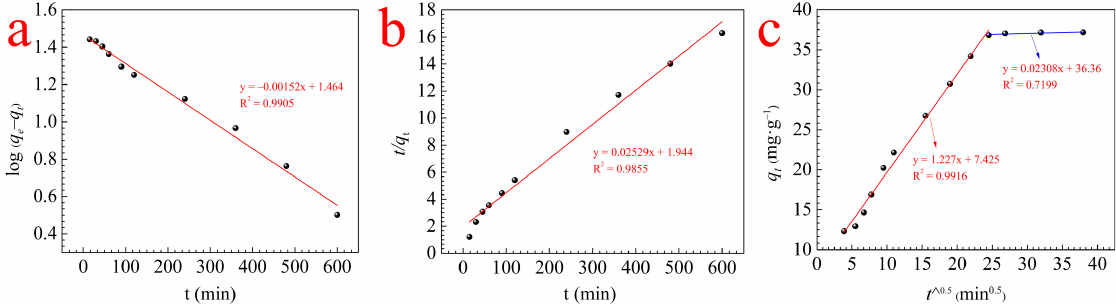
Figure 4. Behavior of RMCR adsorption of calcium ions: fits of the kinetic data of calcium ions adsorption on RMCRs using pseudo-first-order ( a ), pseudo-second-order ( b ), and intraparticle diffusion models ( c ).